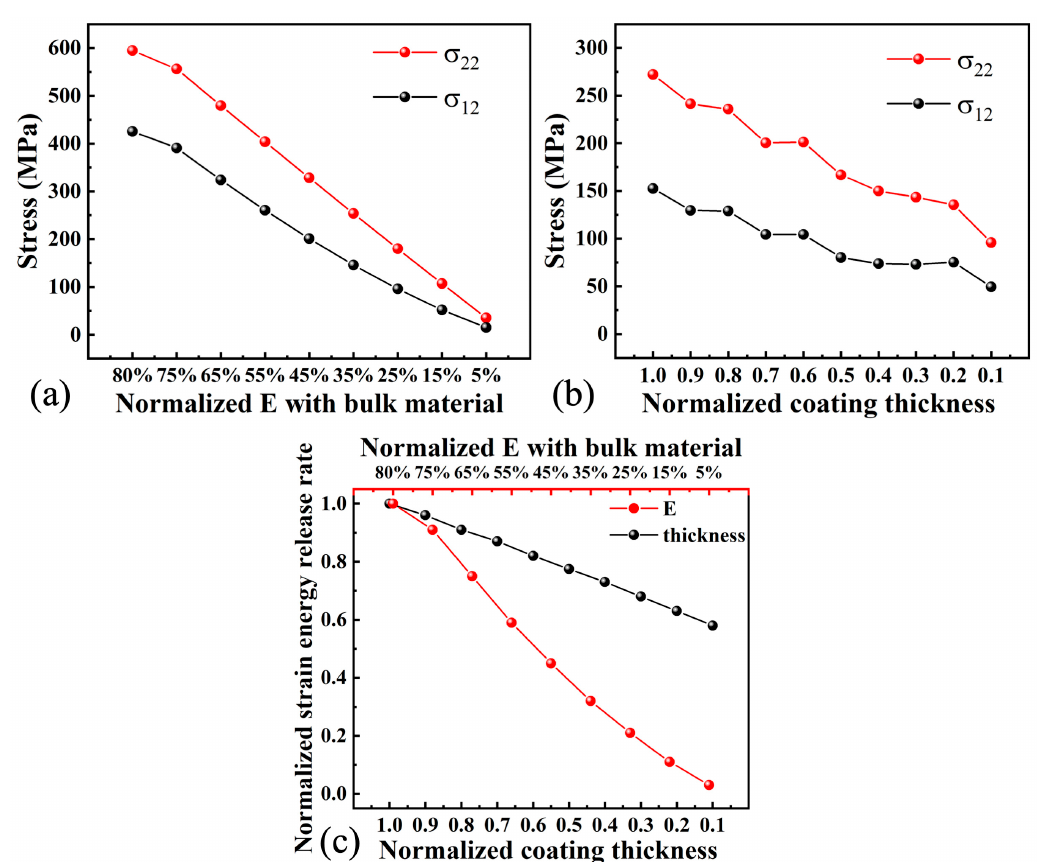
Figure 14. Influence of stiffening degree and TC thickness on stress and SERR: ( a ) stiffening degree, ( b ) TC thickness, ( c ) normalized SERR as functions of the elastic modulus and thickness of TC.